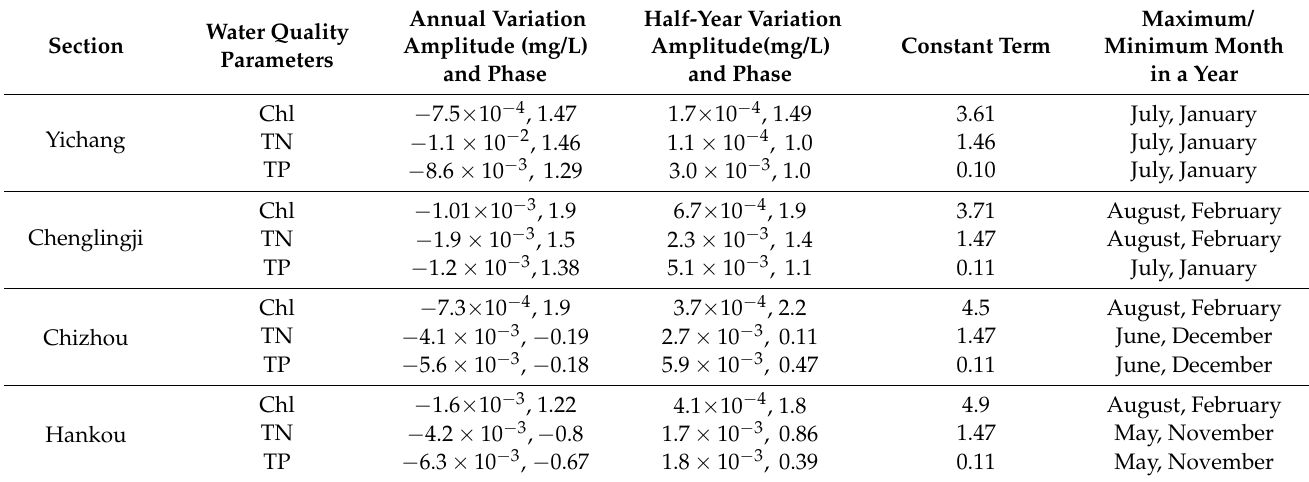
Table 2. Variation amplitudes and phases of Chl, TN and TP in Yichang, Chenglingji, Chizhou, and Hankou section.